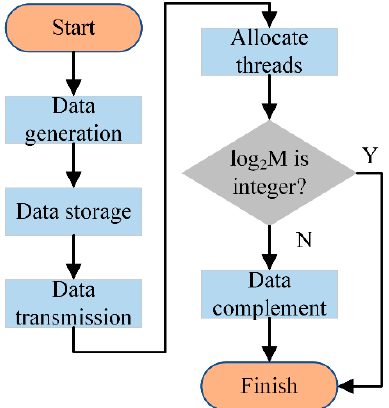
Figure 11. The data processing flow chart of time traces.